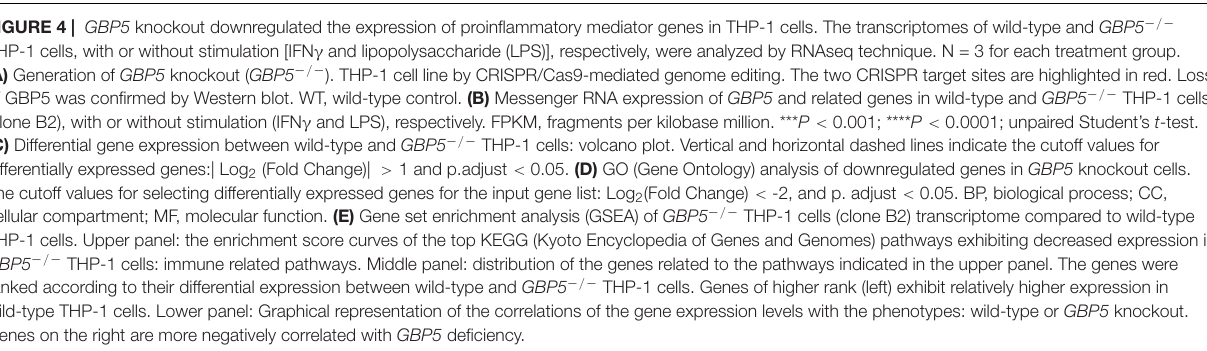
FIGURE 4 | GBP5 knockout downregulated the expression of proinflammatory mediator genes in THP-1 cells. The transcriptomes of wild-type and GBP5 − / − THP-1 cells, with or without stimulation [IFN γ and lipopolysaccharide (LPS)], respectively, were analyzed by RNAseq technique. N = 3 for each treatment group. (A) Generation of GBP5 knockout ( GBP5 − / − ). THP-1 cell line by CRISPR/Cas9-mediated genome editing. The two CRISPR target sites are highlighted in red. Loss of GBP5 was confirmed by Western blot. WT, wild-type control. (B) Messenger RNA expression of GBP5 and related genes in wild-type and GBP5 − / − THP-1 cells (clone B2), with or without stimulation (IFN γ and LPS), respectively. FPKM, fragments per kilobase million. *** P < 0.001; **** P < 0.0001; unpaired Student’s t -test. (C) Differential gene expression between wild-type and GBP5 − / − THP-1 cells: volcano plot. Vertical and horizontal dashed lines indicate the cutoff values for differentially expressed genes:| Log 2 (Fold Change)| > 1 and p.adjust < 0.05. (D) GO (Gene Ontology) analysis of downregulated genes in GBP5 knockout cells. The cutoff values for selecting differentially expressed genes for the input gene list: Log 2 (Fold Change) < -2, and p. adjust < 0.05. BP, biological process; CC, cellular compartment; MF, molecular function. (E) Gene set enrichment analysis (GSEA) of GBP5 − / − THP-1 cells (clone B2) transcriptome compared to wild-type THP-1 cells. Upper panel: the enrichment score curves of the top KEGG (Kyoto Encyclopedia of Genes and Genomes) pathways exhibiting decreased expression in GBP5 − / − THP-1 cells: immune related pathways. Middle panel: distribution of the genes related to the pathways indicated in the upper panel. The genes were ranked according to their differential expression between wild-type and GBP5 − / − THP-1 cells. Genes of higher rank (left) exhibit relatively higher expression in wild-type THP-1 cells. Lower panel: Graphical representation of the correlations of the gene expression levels with the phenotypes: wild-type or GBP5 knockout. Genes on the right are more negatively correlated with GBP5